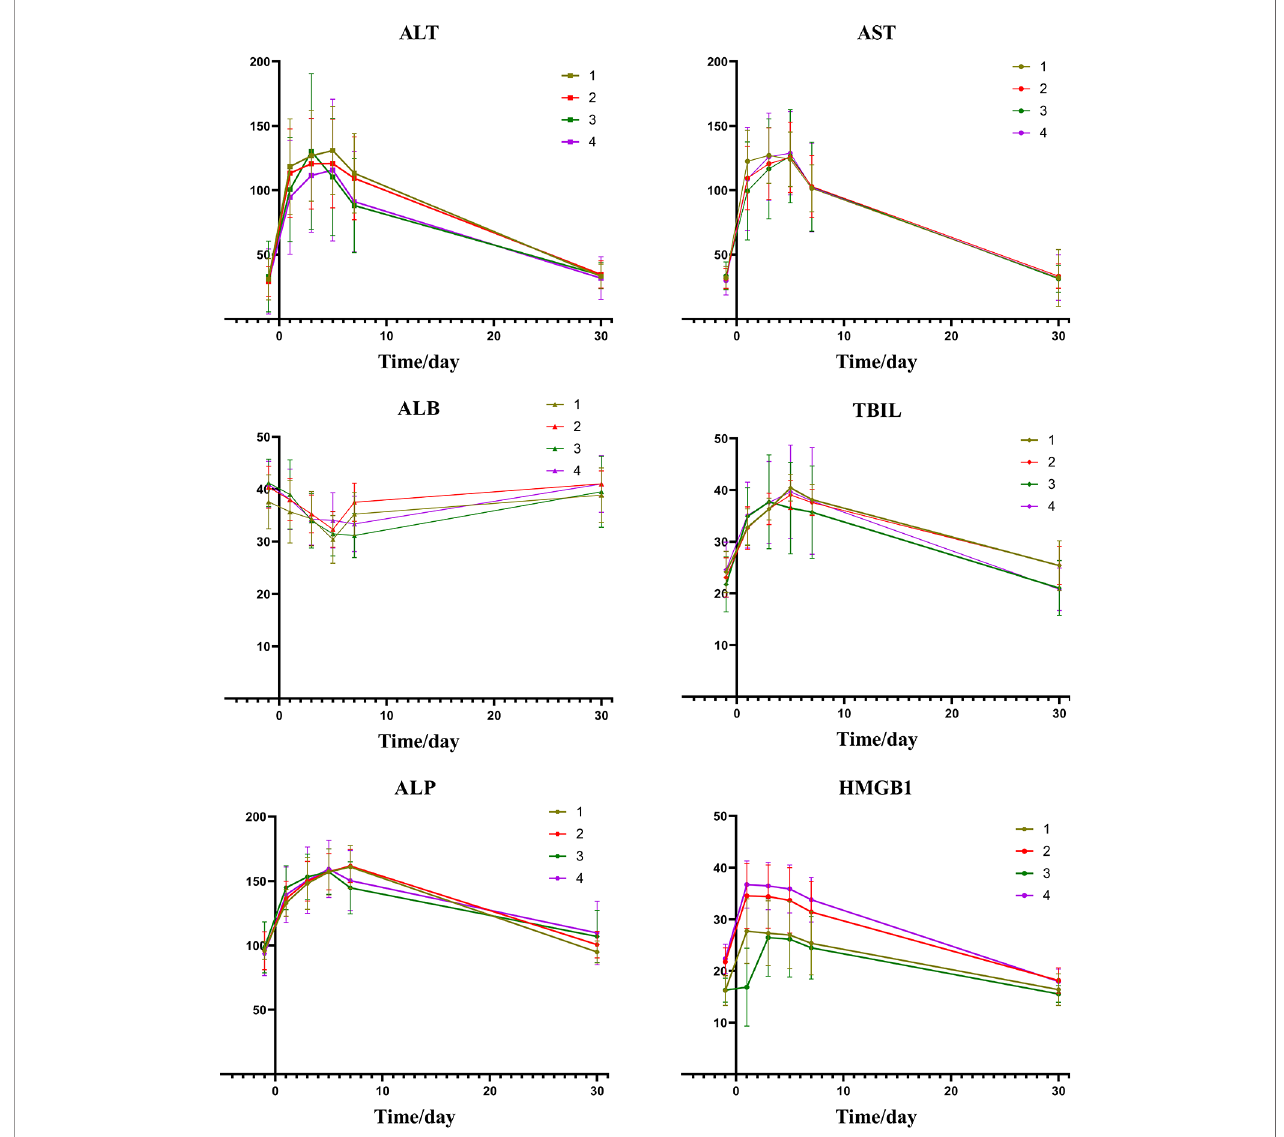
FIGURE 1 | Group1: low pre-expression of HMGB1 with c-TACE; Group2: high pre-expression of HMGB1 with c-TACE; Group3: low pre-expression of HMGB1 with DEB-TACE; Group4: high pre-expression of HMGB1 with